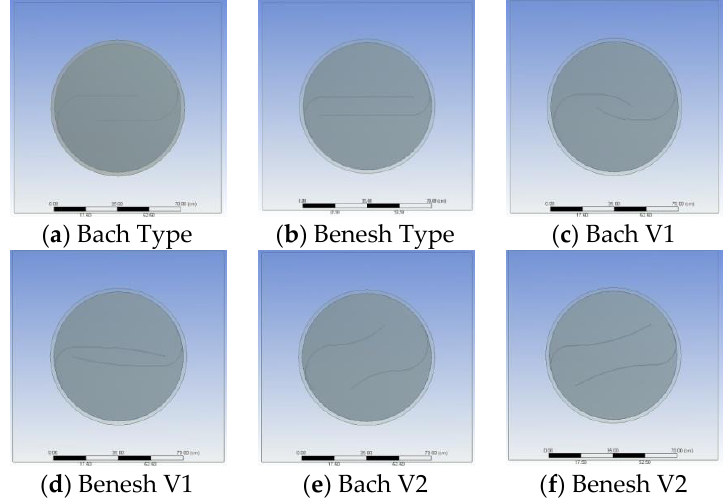
Figure 6. Specific rotor blade section configuration models considered for analysis.